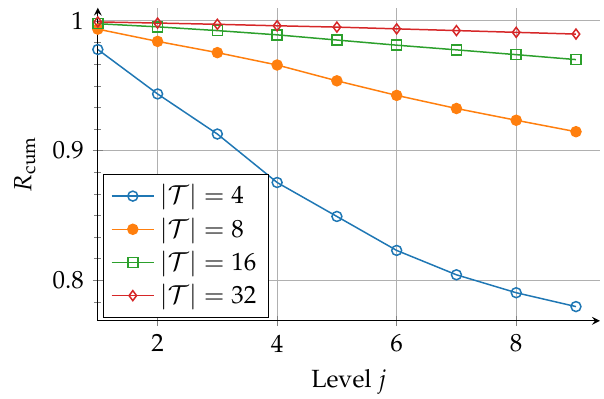
Figure 7. Plot of the cumulative product R cum indicating the amount of mutual information preserved over the levels of a half-rate polar code with N = 512 depending on the number of clusters |T |